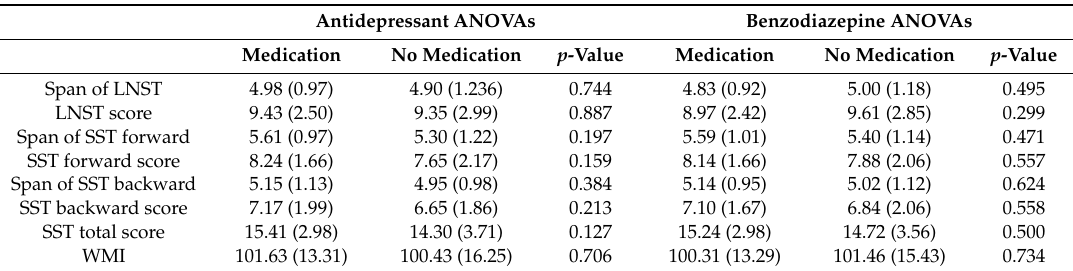
Table 5. Means and standard deviations (in parenthesis) of working memory outcomes for fibromyalgia patients who were taking or not taking medications (benzodiazepines and antidepressants). p -values of the one way-ANOVAs are also